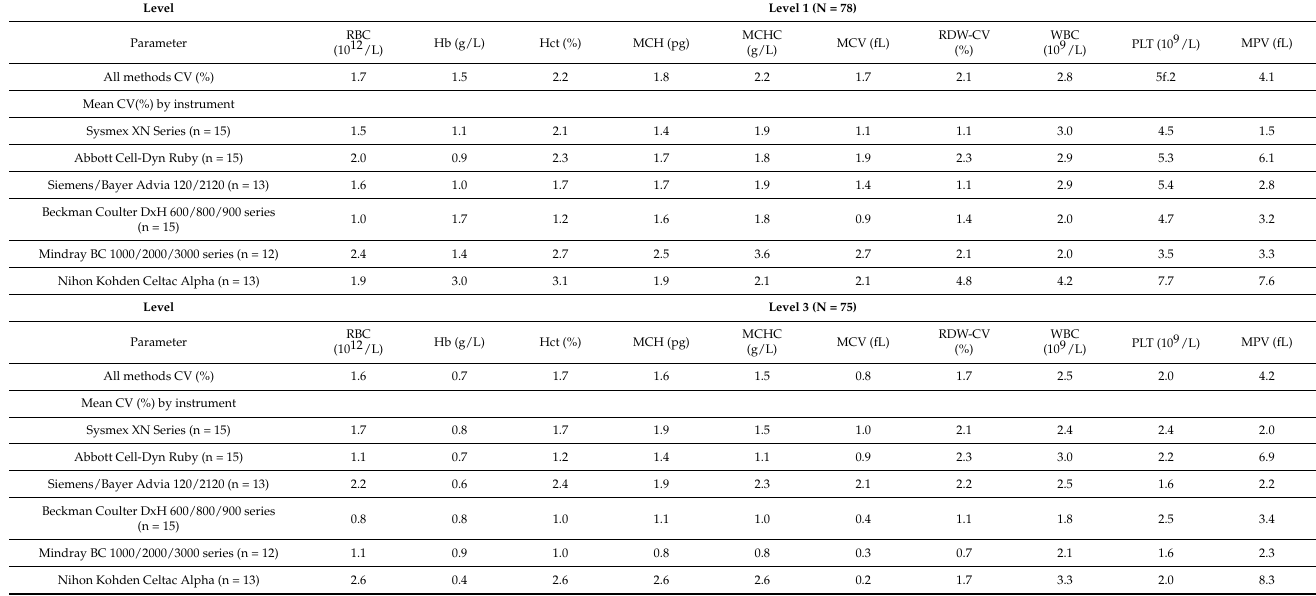
Table 5. CV mean of each instrument group for CBC EQA